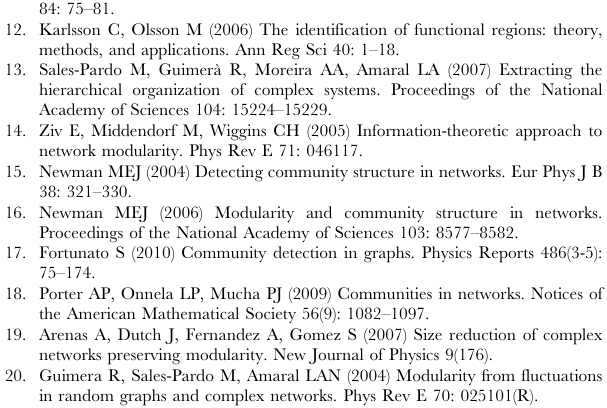
Figure S1 Defining regions through the spectral modularity optimization. Results of five different modularity optimization